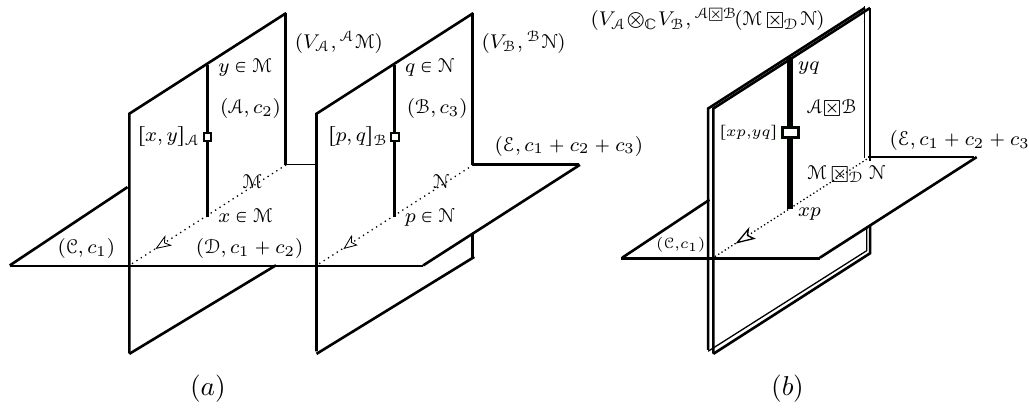
Figure 13 . The picture (a) depicts two chiral gapless domain walls p V A ; A M q and p V B ; B N q . The vertical direction is the direction of time. The picture (b) depicts the new wall obtained after the fusion, where xp : (cid:16) x b D p; yp : (cid:16) y b D q P M b D N . The arrows on the dotted lines are the orientation of the wall. It determines the order of the fusion product of wall